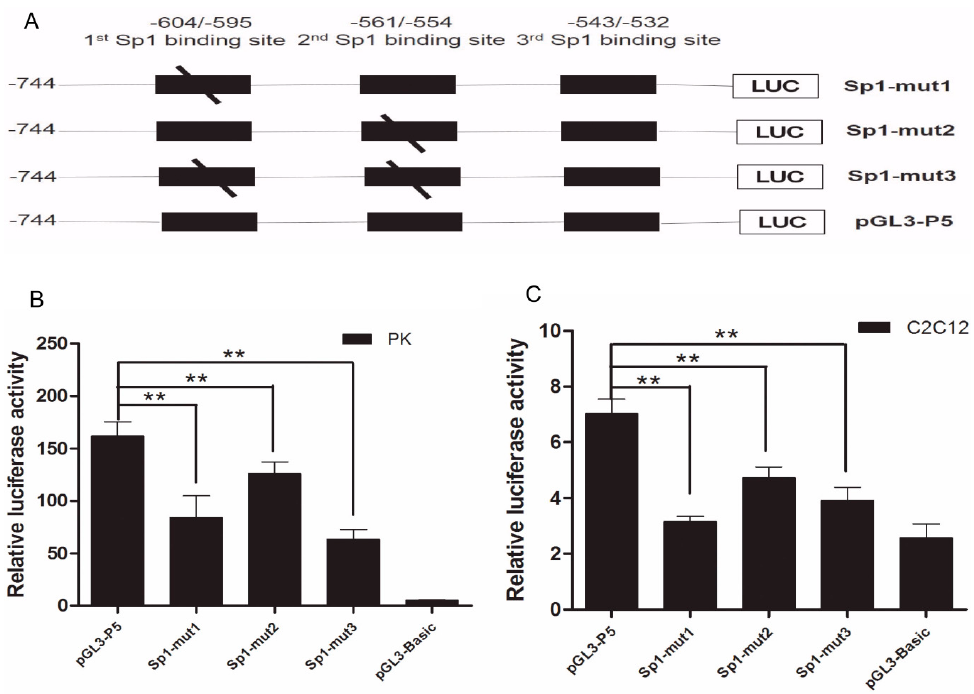
Figure 2. Site-directed mutation of Sp1 binding sites in ROCK1 -P5 fragment. ( A ) Schematic structure of site-directed mutagenesis in the putative Sp1 binding sites (the black slash) of porcine ROCK1 gene. LUC represents the Luciferase gene in the vectors; ( B , C ) Luciferase activity of site-directed mutagenesis in PK and C2C12 cells. Statistical differences of relative activities were analyzed in the same cells; ** p < 0.01, data were expressed as means ± SD of three replicates.